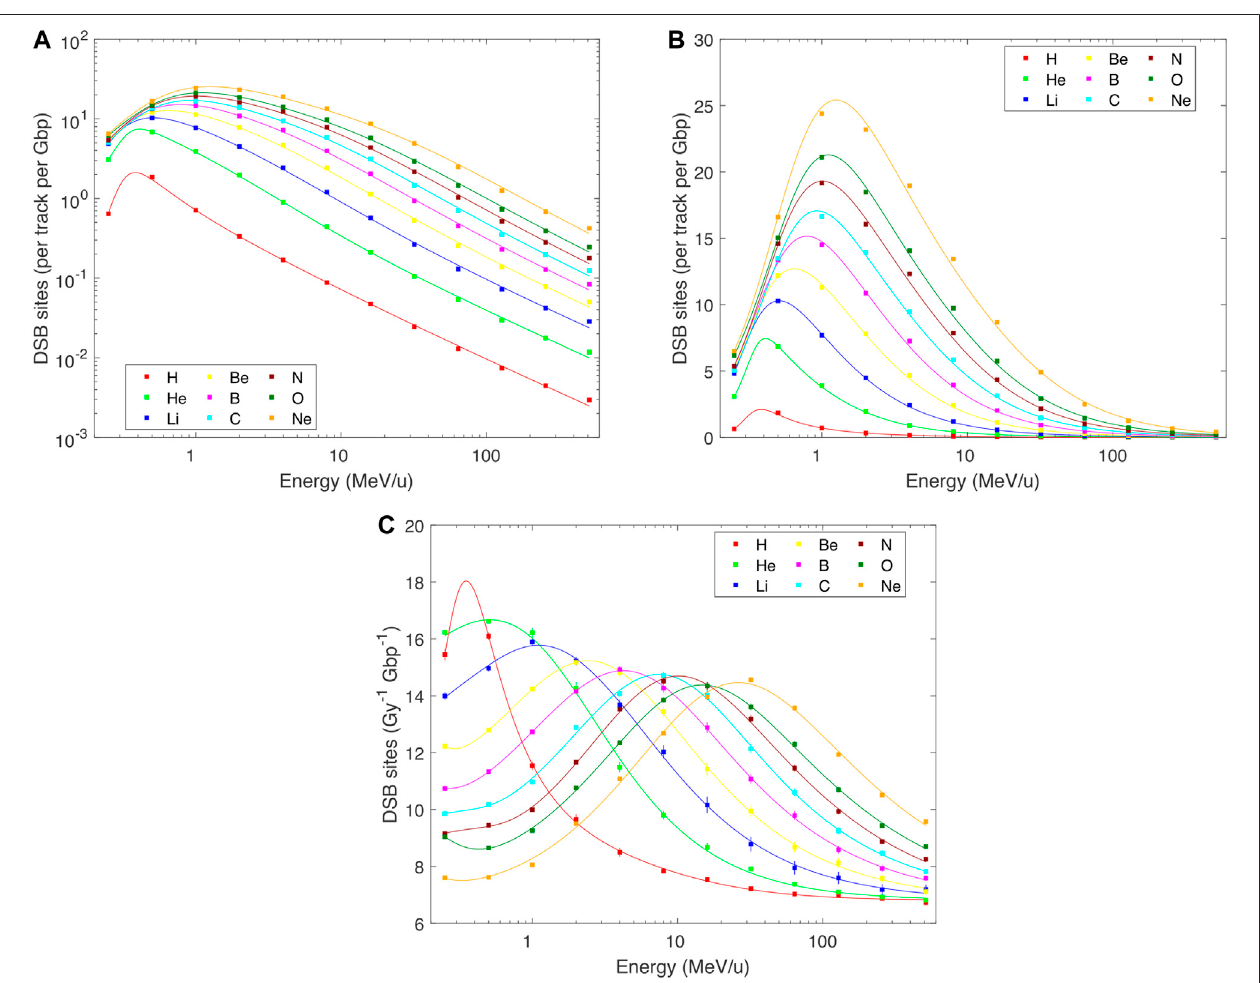
FIGURE4 | PARTRAC simulations on DNA double-strand break sites (DSB sites) induced in human lymphocytesby H – Ne ionswithstarting energiesfrom 0.25 to 512 MeV/u (symbols), fi tted by analytical formulas (lines). Error bars depict estimated 95% con fi dence intervals of the simulated results. Where error bars are not visible, they are smaller than the symbols. Panels (A,B) : yields per track per Gbp, in logarithmic and linear scales, calculated as a product of Eqs 1 and 2 , details in the text; panels (C) : yield per Gy per Gbp, in linear scale, fi tted by Eq. 2 with parameters in Table 2 .